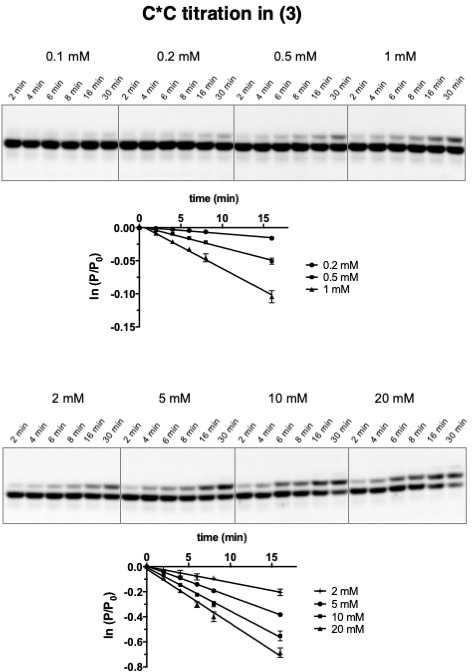
Representative denaturing PAGE data and plots of ln(P/P0) vs. time for the reaction kinetics in case (3) as described in Figure 4.